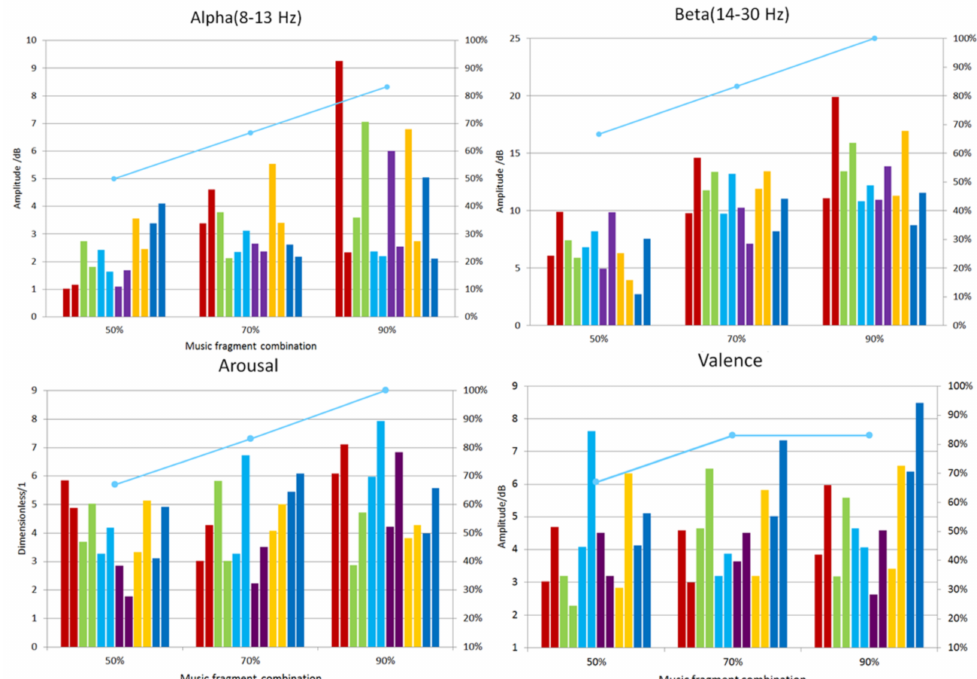
Figure 5. The average power distribution of the music segment reconstructed with different duty cycles. The upper graph shows the distribution characteristics of the average power variation of the α - β band under different duty cycles; the lower graph shows the variation distribution characteristics of the quantized Arousal and Valence values (the light green broken line in the graph is the percentage of the normal frequency and the total number of experiments).